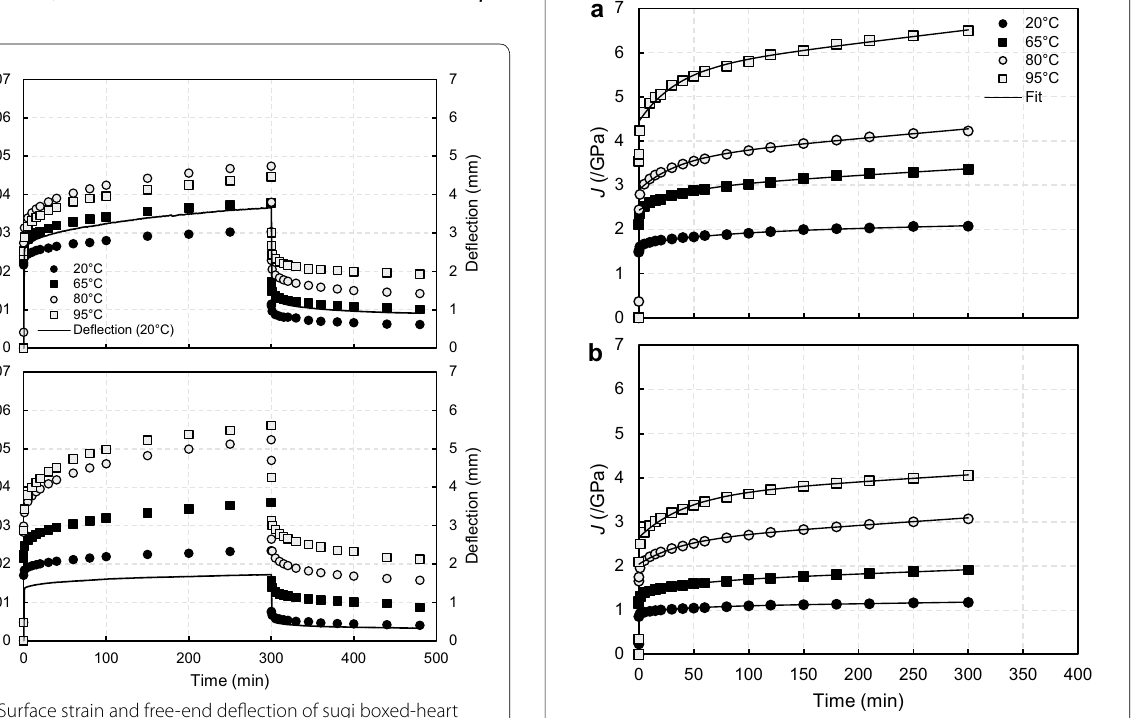
Fig. 5 Creep compliance of sugi boxed-heart timber at each temperature. a Surface-layer specimen; b inner-layer